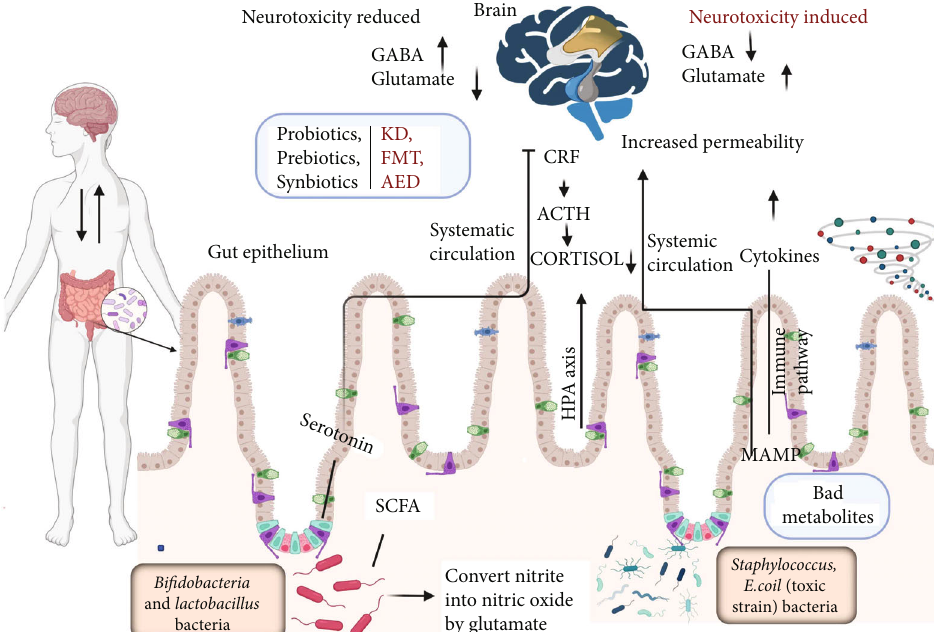
Figure 3: Possible mechanisms responsible for the e ff ect of the digestive tract microbiome on the pathogenesis of ALS. Microbial metabolic end products may indirectly in fl uence the central nervous system (CNS) through immune system modulation. Toxins and neuroactive metabolites produced by a damaged intestinal epithelial barrier or enteric bacteria can overcome the blood-brain barrier, di ff use to the systemic circulation, and impact on ALS pathogenesis. Metabolites produced by bacteria can alter energy homeostasis, encourage oxidative stress, and cause mitochondrial dysfunction and neuroin fl